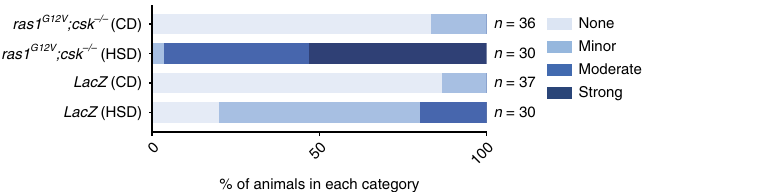
Fig. 1 HSD-fed Ras/Src-animals exhibit systemic muscle wasting. ras1 G12V ;csk − / − third-instar larvae raised on CD ( a ) or HSD ( b ). Transformed tissue is labelled with GFP (green). Secondary tumours are observed in a subset of animals (arrowheads in b ). Scale bar, 500 μ m. a ′ , b ′ Matching dissected eye epithelial tissue stained with DAPI (red). Scale bar, 250 μ m. Nile Red (red) and DAPI (blue) staining of dissected fat body tissue from ras1 G12V ;csk − / − third- instar larvae fed a CD ( c ) or HSD ( d ). Scale bar, 100 μ m. F-actin (red) staining of dissected larval body-wall muscle tissue from ras1 G12V ;csk − / − third-instar larvae raised on CD ( e ) or HSD ( f ). Scale bar, 100 μ m. LacZ third-instar larvae raised on CD ( g ) or HSD ( h ). LacZ -expressing eye tissue is labelled with GFP (green). Scale bar, 500 μ m. g ′ , h ′ Matching dissected eye epithelial tissue stained with DAPI (red). Scale bar, 250 μ m. Nile Red (red) and DAPI (blue) staining of dissected fat body tissue from LacZ third-instar larvae fed a CD ( i ) or HSD ( j ). Scale bar, 100 μ m. F-actin (red) staining of dissected larval body- wall muscle tissue from ras1 G12V ;csk − / − third-instar larvae fed a CD ( k ) or HSD ( l ). Scale bar, 100 μ m. m Matching body-wall muscle wasting quanti fi cation. X -axis represents the percentage of individual animals scoring in each category denoted ‘ none', ‘ minor', ‘ moderate' or ‘